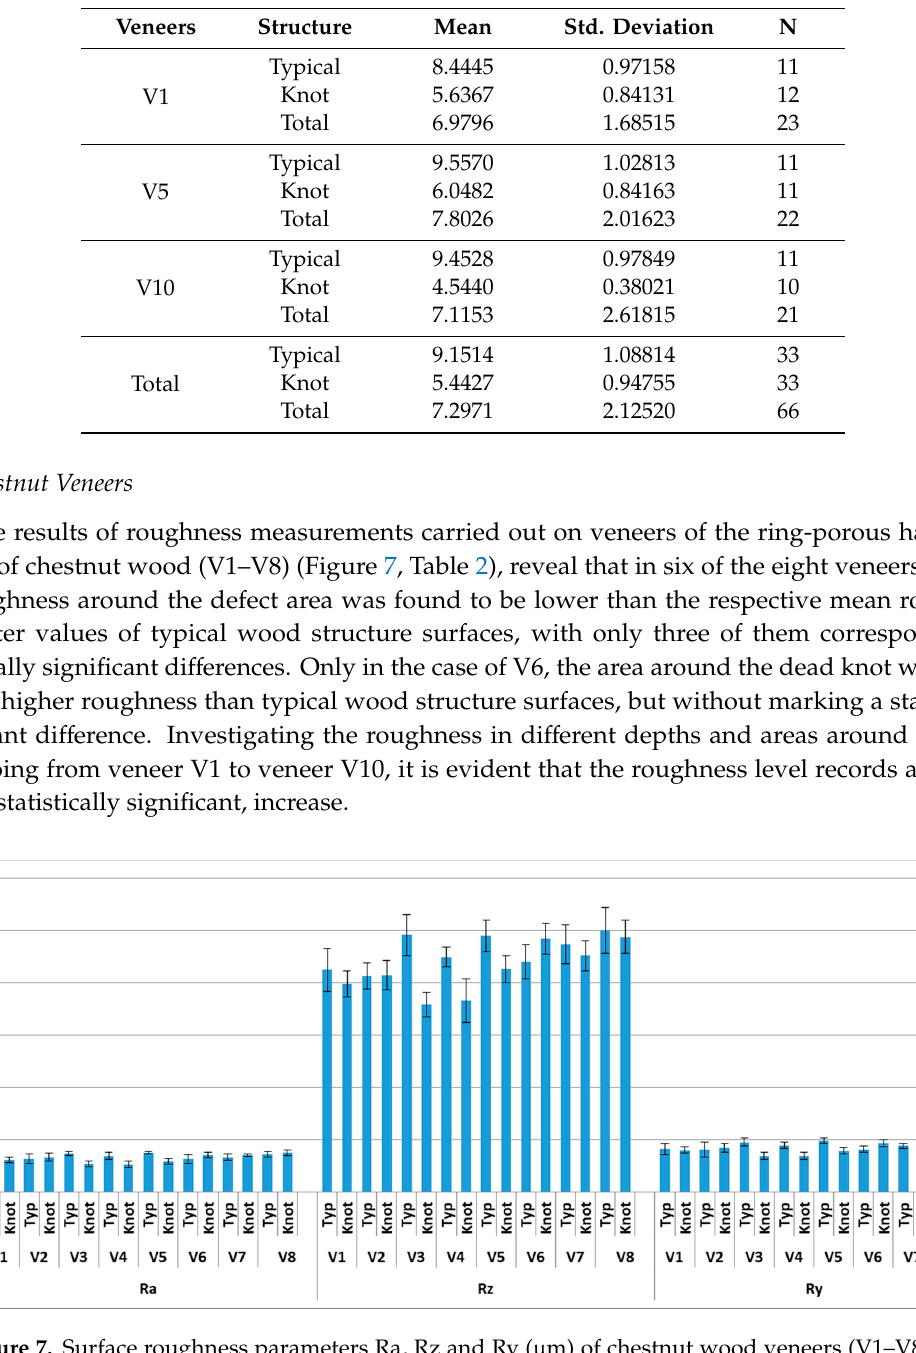
Figure 7. Surface roughness parameters Ra, Rz and Ry (µm) of chestnut wood veneers (V1–V8) on typical wood structure areas and areas around dead knot. Table 2. Descriptive statistics of dependent variable Ra measured on chestnut veneers of typical and non-typical structure around the knot.